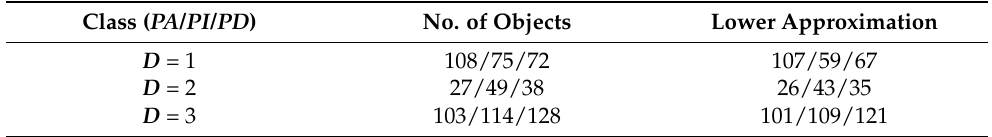
Table 4. Quality approximation of decision